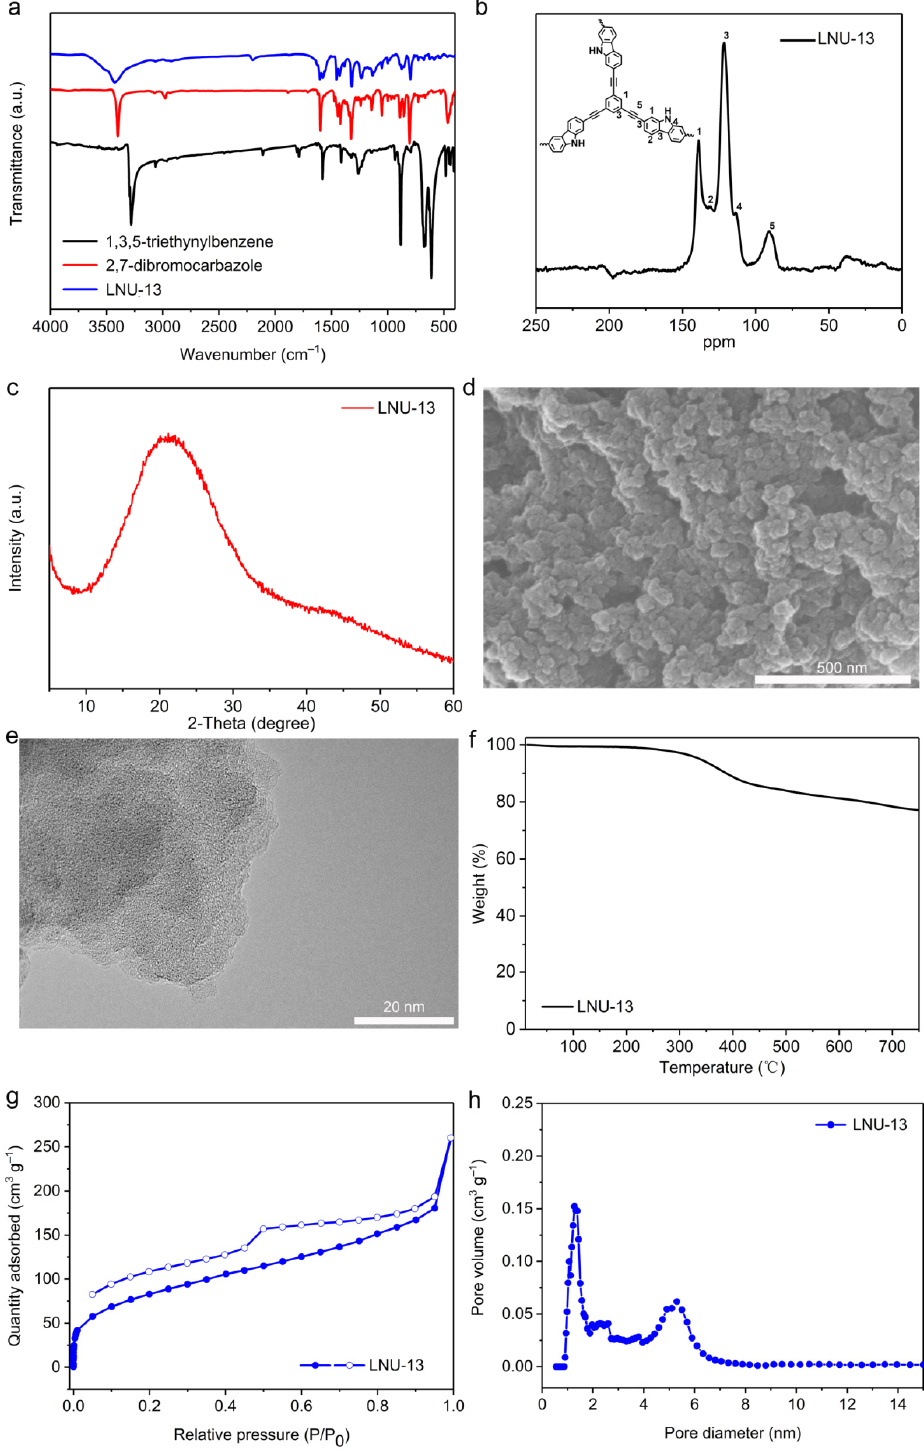
Figure 2. ( a ) FTIR spectra of 2,7-dibromocarbazole, 1,3,5-triethynylbenzene, and LNU-13; ( b ) solid-state 13 C NMR spectrum of LUN-13; ( c ) powder X-ray diffraction pattern of LNU-13. ( d ) SEM image of LNU-13; ( e )TEM image of LNU-13; ( f ) TGA plot of LNU-13 at N 2 condition with a ramp rate of 5 ◦ C min − 1 ; ( g ) N 2 adsorption-desorption isotherm of LNU-13; ( h ) pore size distribution of